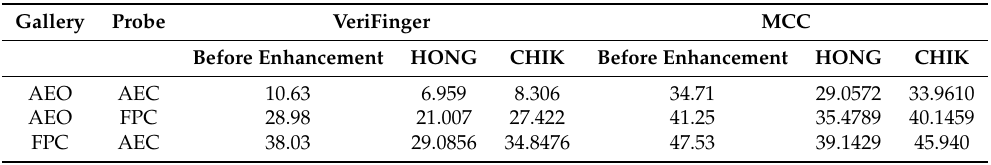
Table 2. Match error rate (EER) of the VeriFinger and Minutiae Cylinder-Code (MCC) algorithms before and after